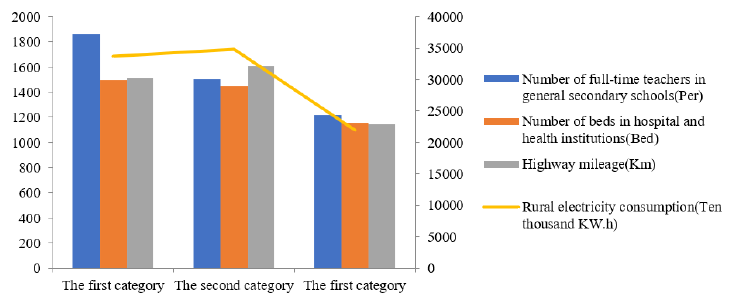
Fig. 6 A comparison of life quality of county populations across the three categories.